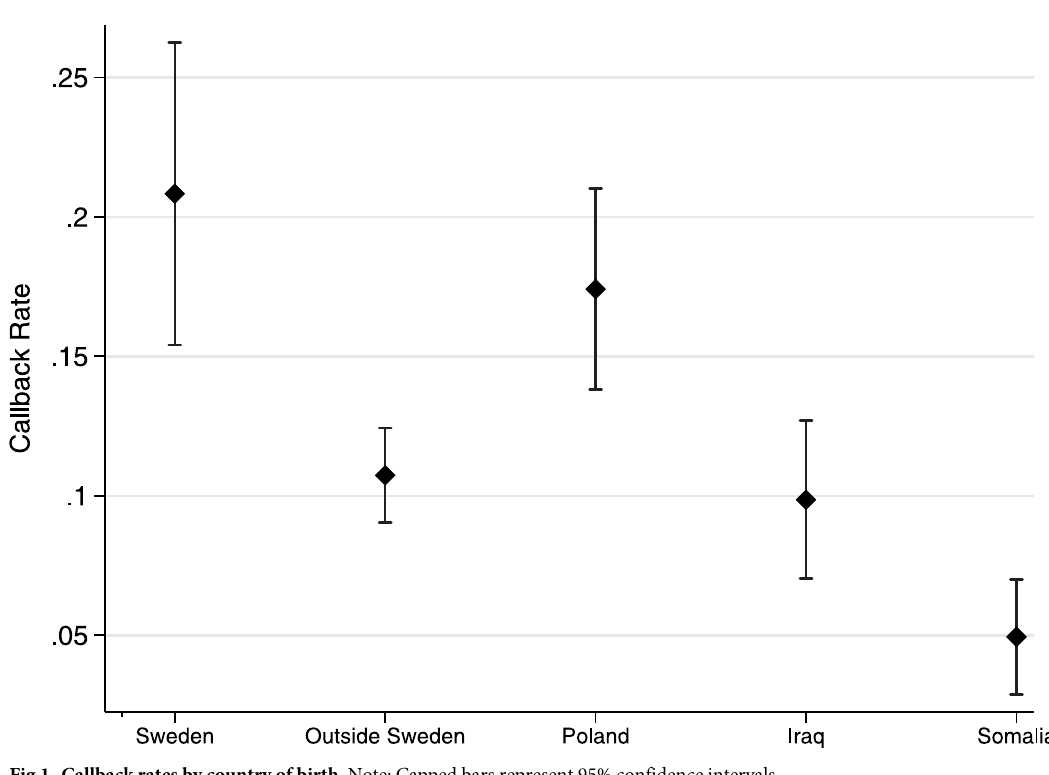
Fig 1. Callback rates by country of birth. Note: Capped bars represent 95% confidence intervals.